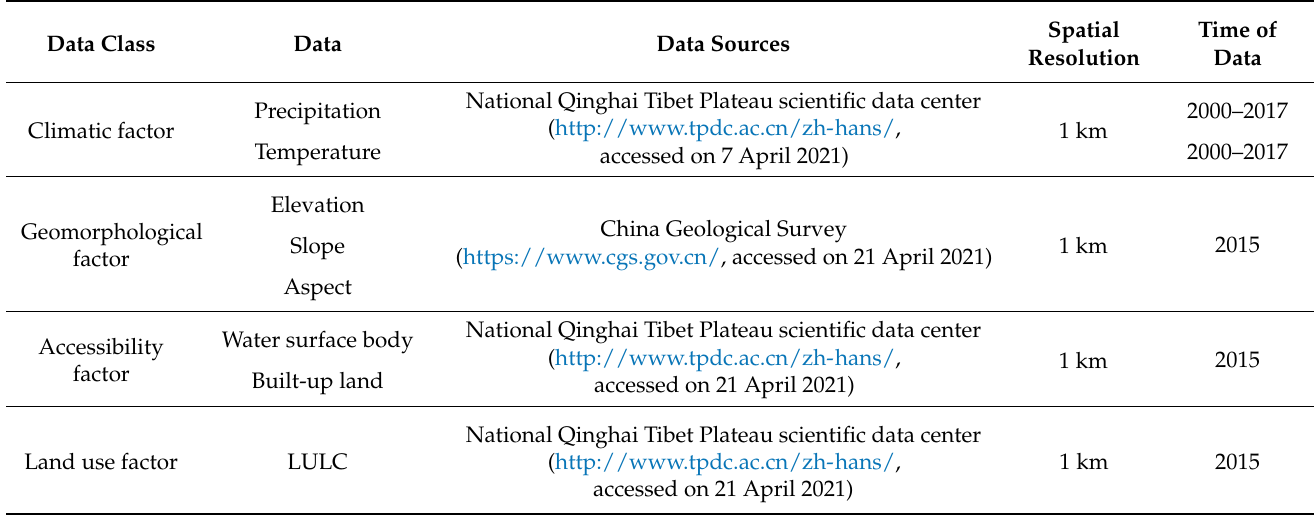
Table 1. Data and data